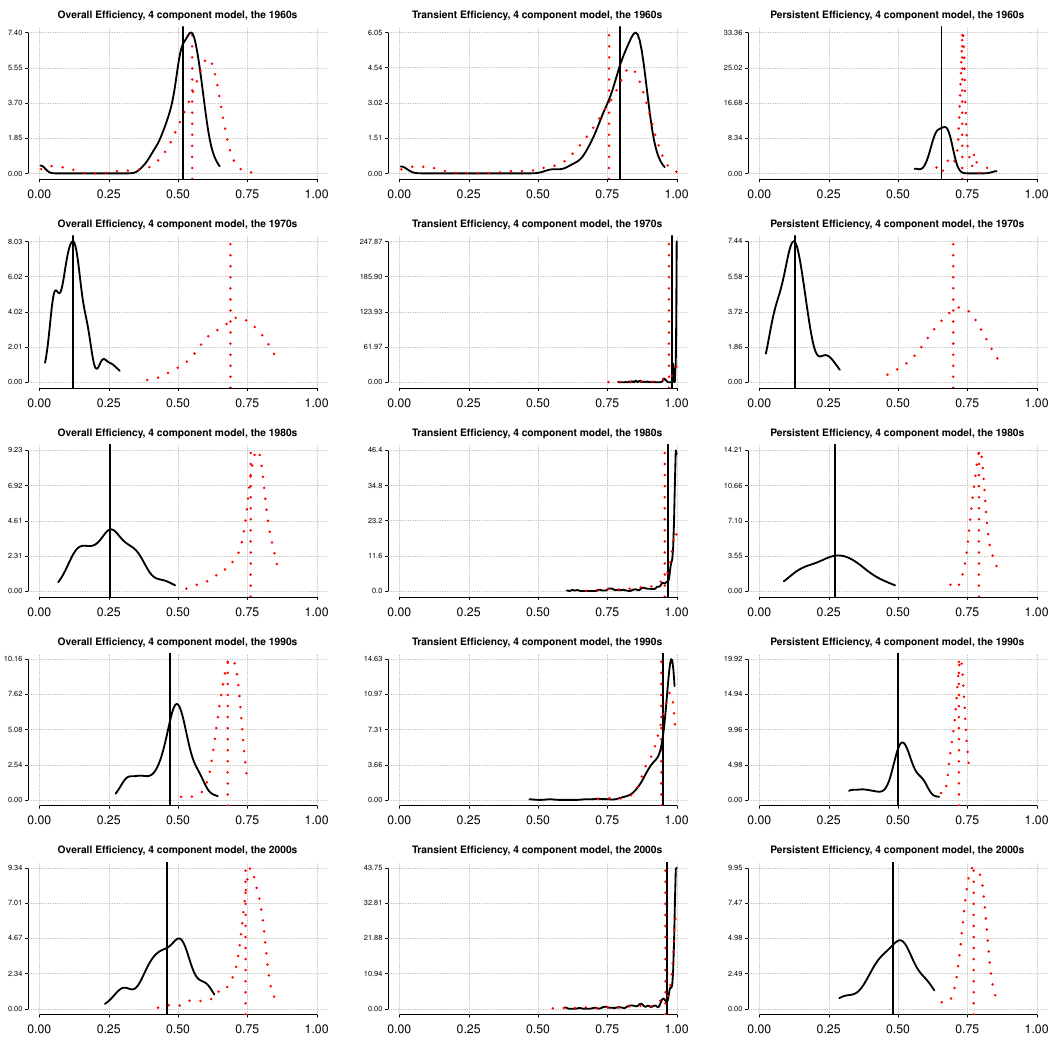
Figure 5. Overall, transient and persistent energy efficiency, Model 2. Notes: Solid black curves are high energy-intensive industries, dotted red curves are low energy-intensive industries. Vertical lines are respective mean